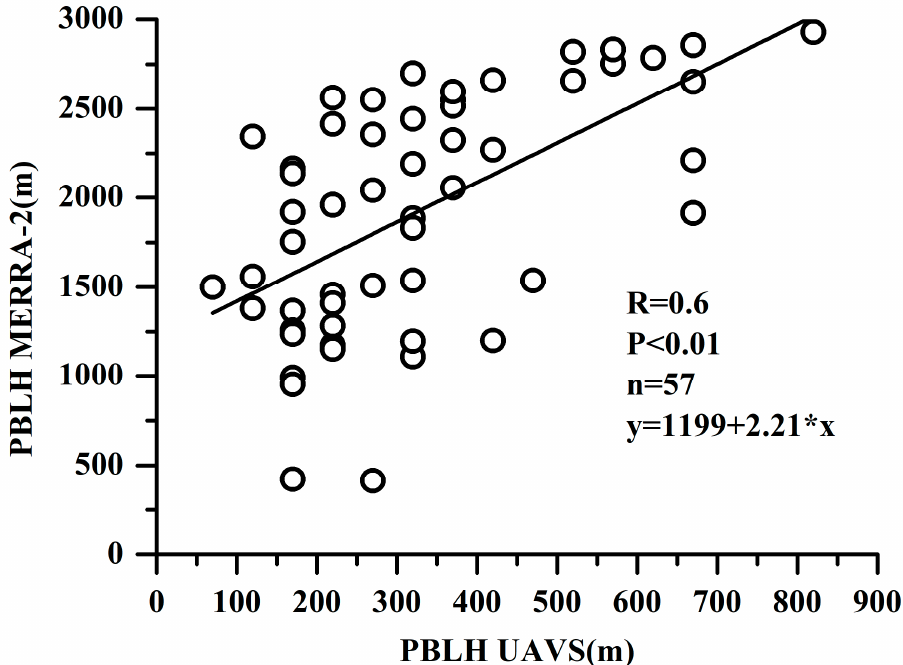
Figure 2. Comparisons of PBLH derived from the UAVS and MERRA-2.